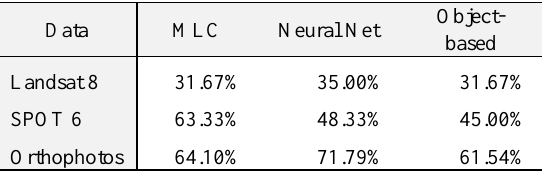
Table 8. Accuracy tested using 1:5,000 topographical maps